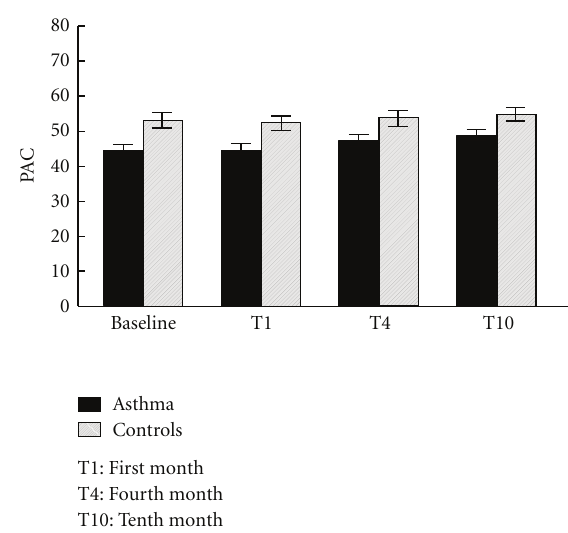
Figure 1: Mean PAC (mLO 2 /min/kg) with SE in the asthmatic and control groups of children according to four observation